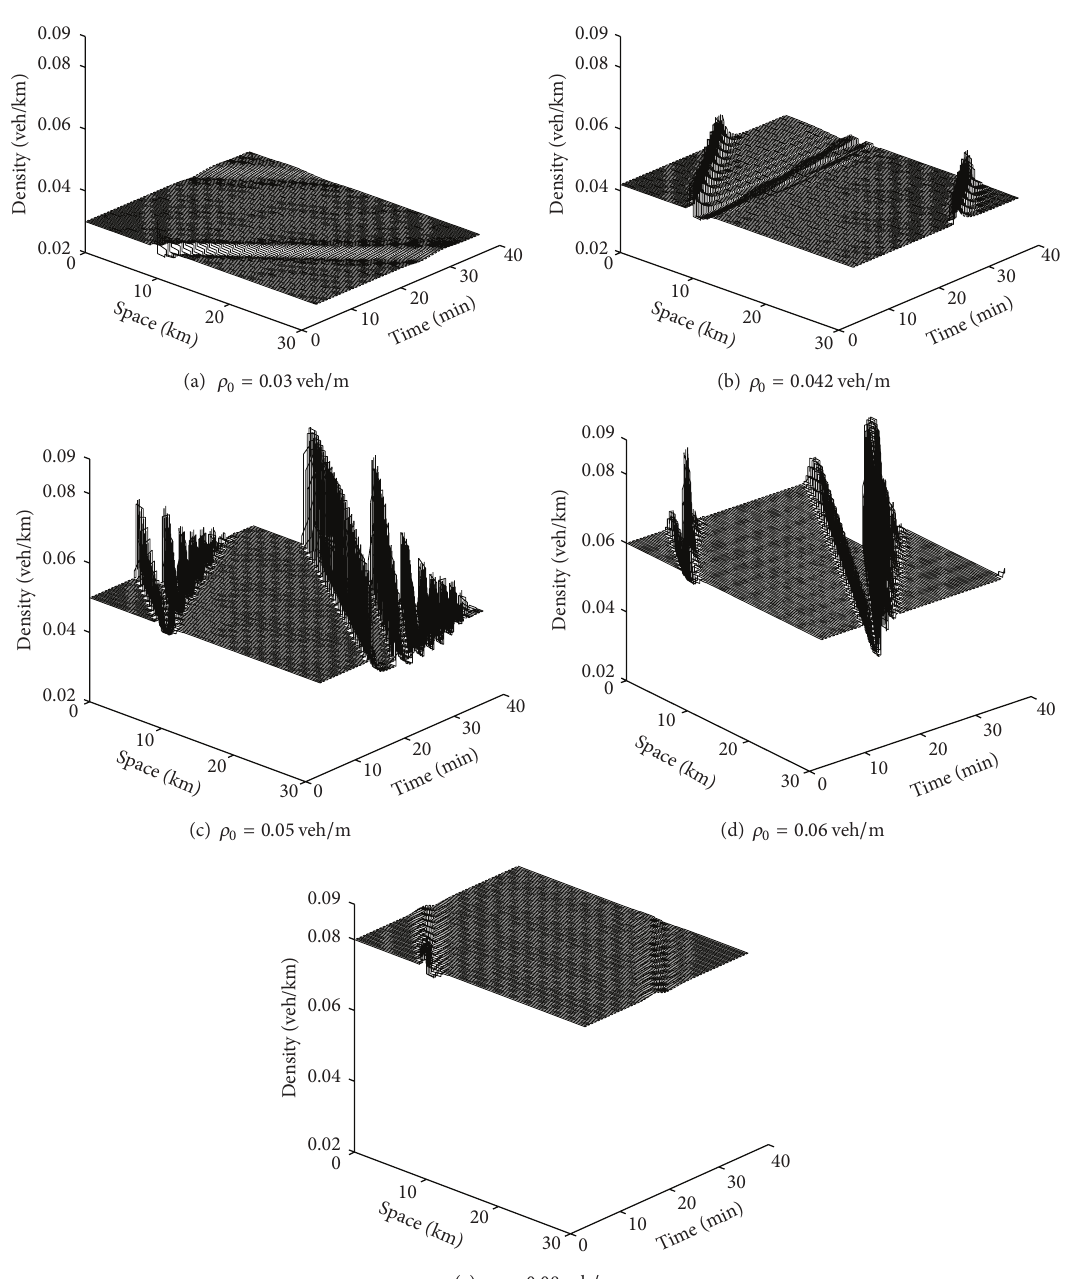
Figure 1: Temporal evolution of traffic flow before 40 minutes for different 𝜌 0 with 𝛽 = 0.2